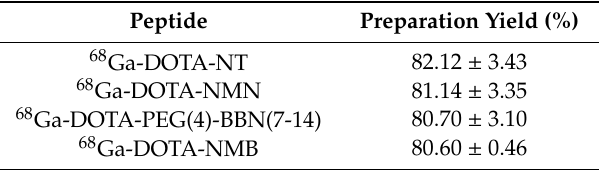
Table 1. The overall preparation yield of radiolabelled peptides.